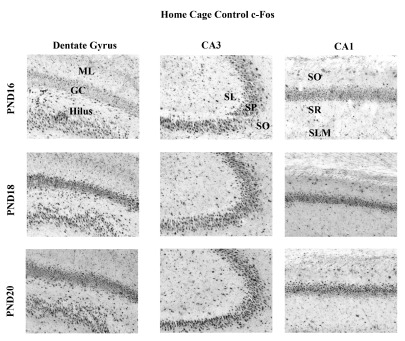
Representative c-Fos labeling in the hippocampus.Representative images for immunohistochemical localization of c-Fos in the dentate gyrus (DG), CA3 and CA1 regions from rats included in the HCC condition. Top row shows sections from PND16; middle row from PND18; bottom row from PND20. Images were taken at 10×. Abbreviations: ML: molecular layer of the dentate gyrus; GC: granule cells; S:
stratum lucidum; SP:
stratum pyramidale; SO:
stratum oriens; SR:
stratum radiatum; SLM:
stratum lacunosum moleculare.